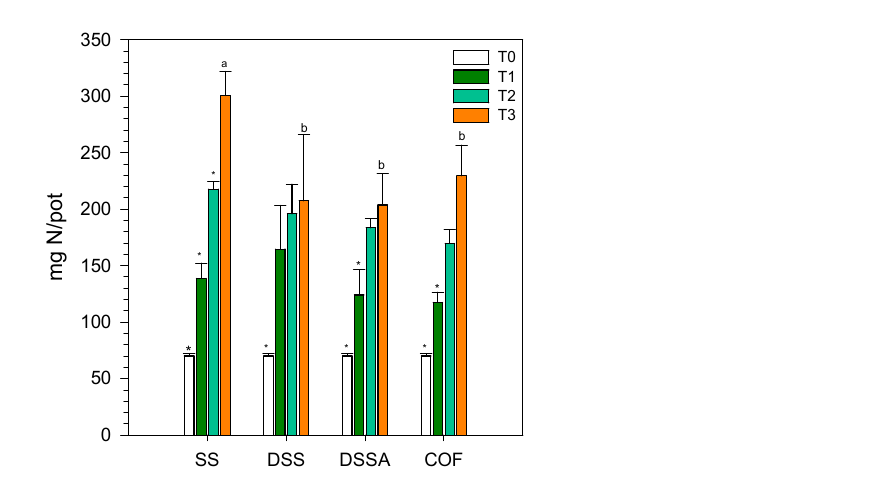
Figure 4. N offtake by lettuce as a function of treatment and added soil amendment material (T0—0 kg N/ha; T1—85 kg N/ha; T2—170 kg N/ha; T3—255 kg N/ha; mean values and standard deviations obtained in four replicates of each treatment; different letters indicate statistical differences between materials; * indicate statistical differences between treatment within each